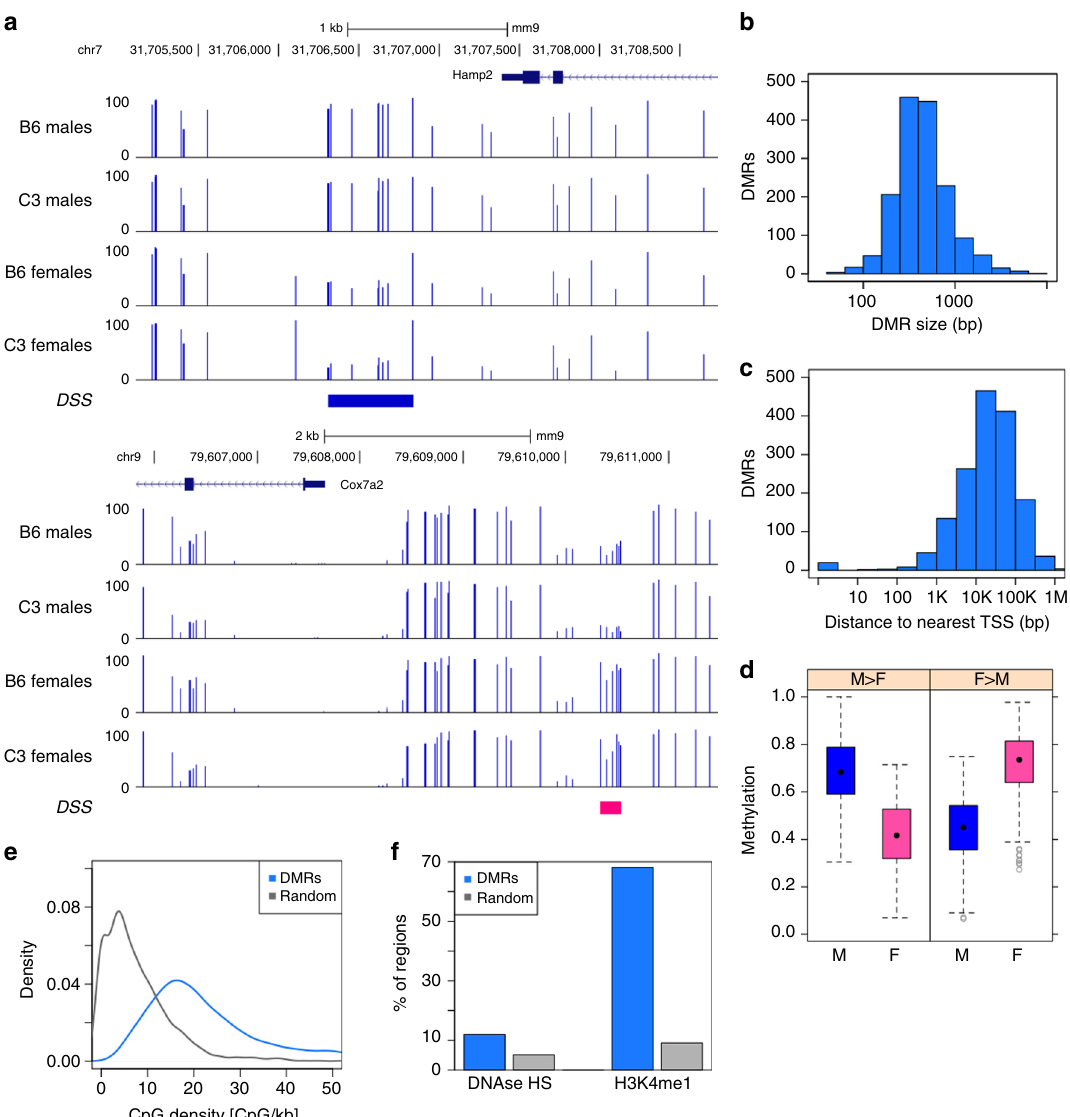
Fig. 5 DMRs between male ( n = 6) and female ( n = 6) parental animals, identi fi ed by DSS. a Genome browser view of example M > F DMR (blue, top) and F > M DMR (pink, bottom). b Distribution of DMR size, N = 1575. c Distribution of distance between DMR and nearest TSS (based on RefSeq gene models as of Feb 8, 2016), N = 1575. d Distribution of methylation level in DSS DMRs, by strain and DMR polarity. N = 1041 F > M DMRs and 534 M > F DMRs. The box depicts the 25th to 75th percentiles (color by sex where male is blue and female is pink), the black dot is the median, the whiskers extend to data points up to 1.5*IQR beyond the box, and open gray circles are data points outside the whisker range. e Distribution of CpG density at DSS DMRs ( N = 1575), compared to size-matched random genomic regions ( N = 1575). f Overlap of DSS DMRs ( N = 1575) with DNase hypersensitive sites (UCSC Genome Browser) and H3K4me1 enriched regions (ENCODE peaks ENCFF001XXZ), compared to the average overlap observed for 1000 iterations of